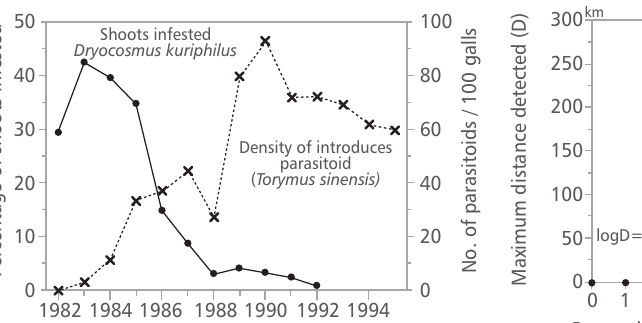
FIGURE 1. Decrease in infestation rate with Dryocosmus kuriphilus after the release of Torymus sinensis in Japan (source Moriya et al. [42])